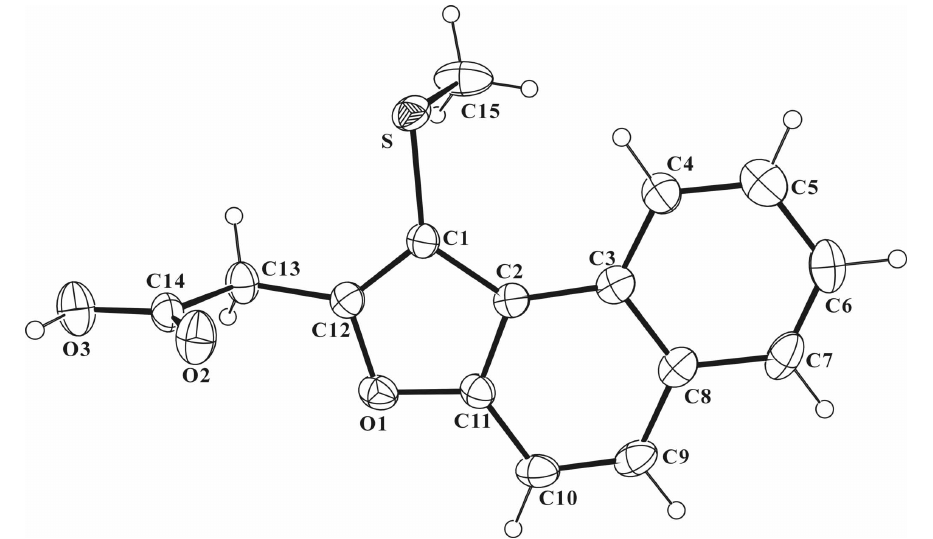
Figure 1 The molecular structure of the title compound with the atom numbering scheme. Displacement ellipsoides are drawn at the 30% probability level. H atoms are presented as a small spheres of arbitrary radius.